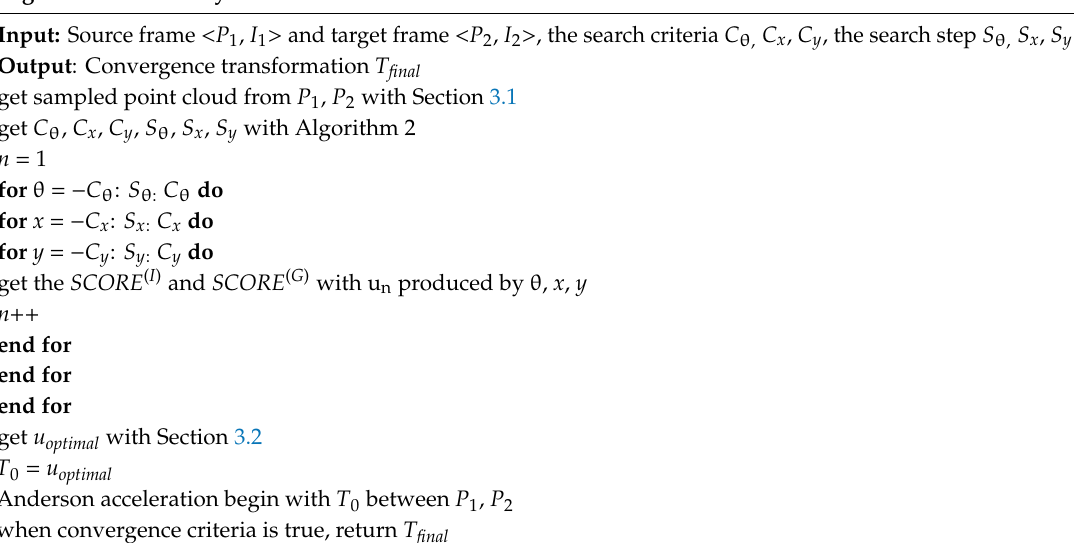
Algorithm 1: Intensity-Assisted